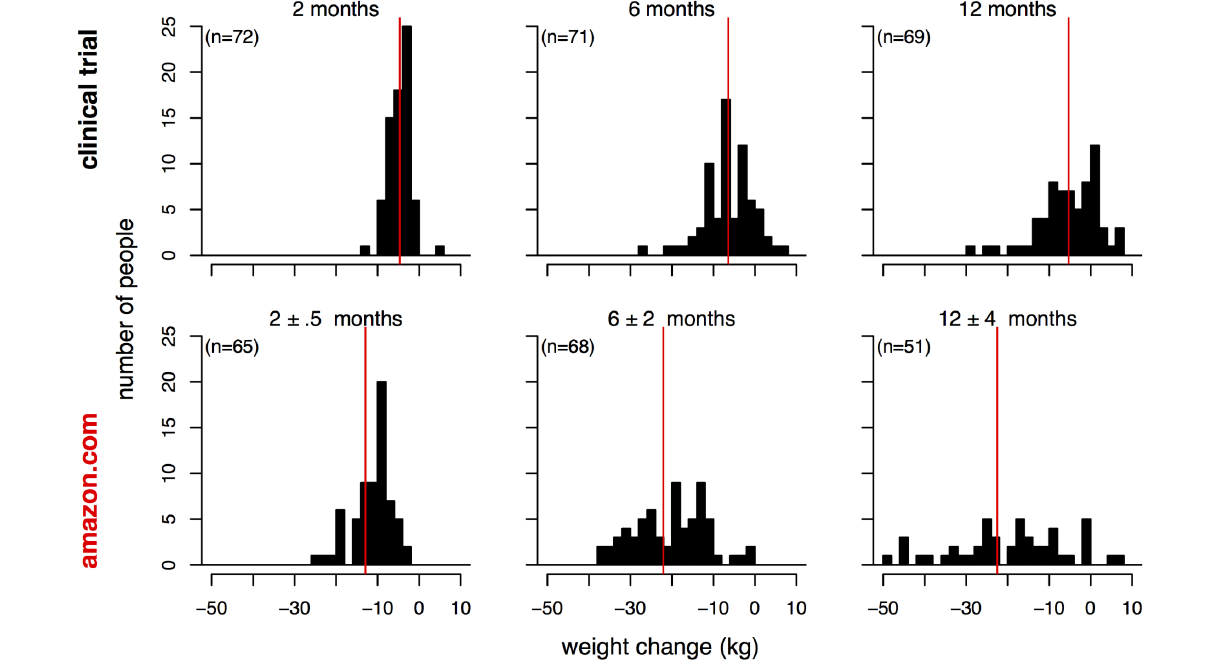
Figure 2. Comparison of weight loss distributions on Amazon reviews (bottom row) and clinical trial (11, top row) at three time points. Horizontal red lines indicate mean weight change. Outliers with weight loss >50 kg are not shown but are included in mean calculation.